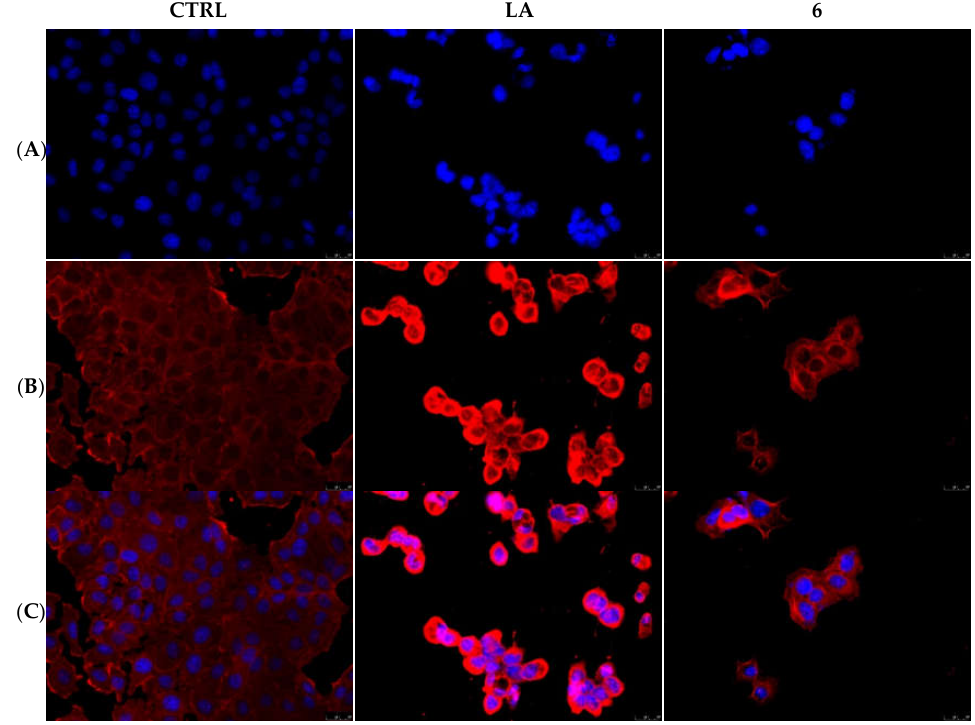
Figure 4. Actin immunofluorescence studies. MCF-7 cells were exposed to compound 6 (used at its IC 50 value), with 0.1 μM Latrunculin A (LA) or with a vehicle (CTRL) for 24 h. Then the cells were further processed, observed and imaged under the inverted fluorescence microscope at 40× magnification. CTRL cells showed a regular arrangement and organization of the actin cytoskeleton. MCF-7 cells exposed to LA and, as well as those treated with compound 6, showed an irregular arrangement and organization of the actin system. Panels ( A ): nuclear stain with DAPI (λ ex /λ em = 350/460 nm); Panels ( B ): β-actin (Alexa Fluor ® 568; λ ex /λ em = 644/665 nm); Panels ( C ): show a merge. Representative fields are shown.